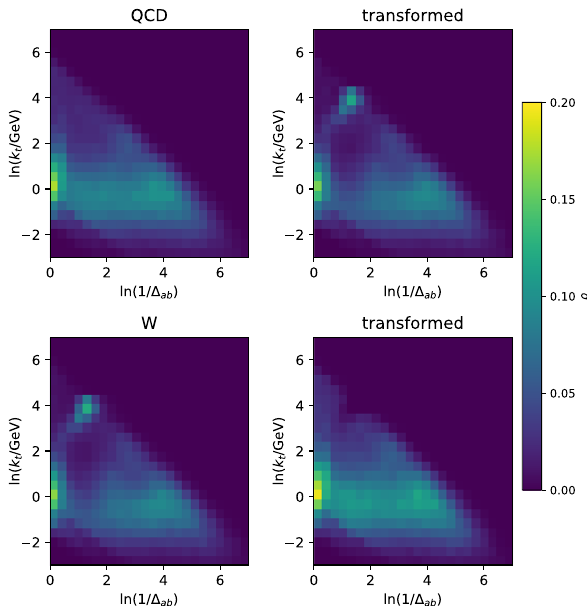
Fig. 13 Top: average of the QCD sample before (left) and after (right) applying the QCD-to- W mapping. Bottom: average of the W sample before (left) and after (right) applying the W -to-QCD mapping